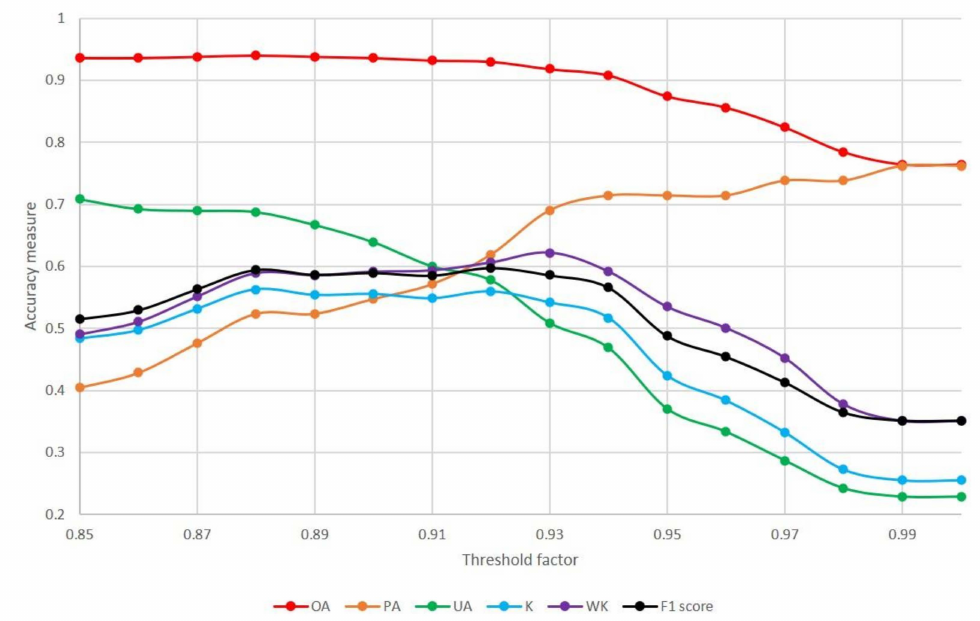
Figure 4. PA and UA of the change class; OA and WK comparison for all values of h. Note that for UA, OA, K, and F1 score, partial-change is counted as no-change . For WK, partial-change is in half agreement with change , and full agreement with no-change